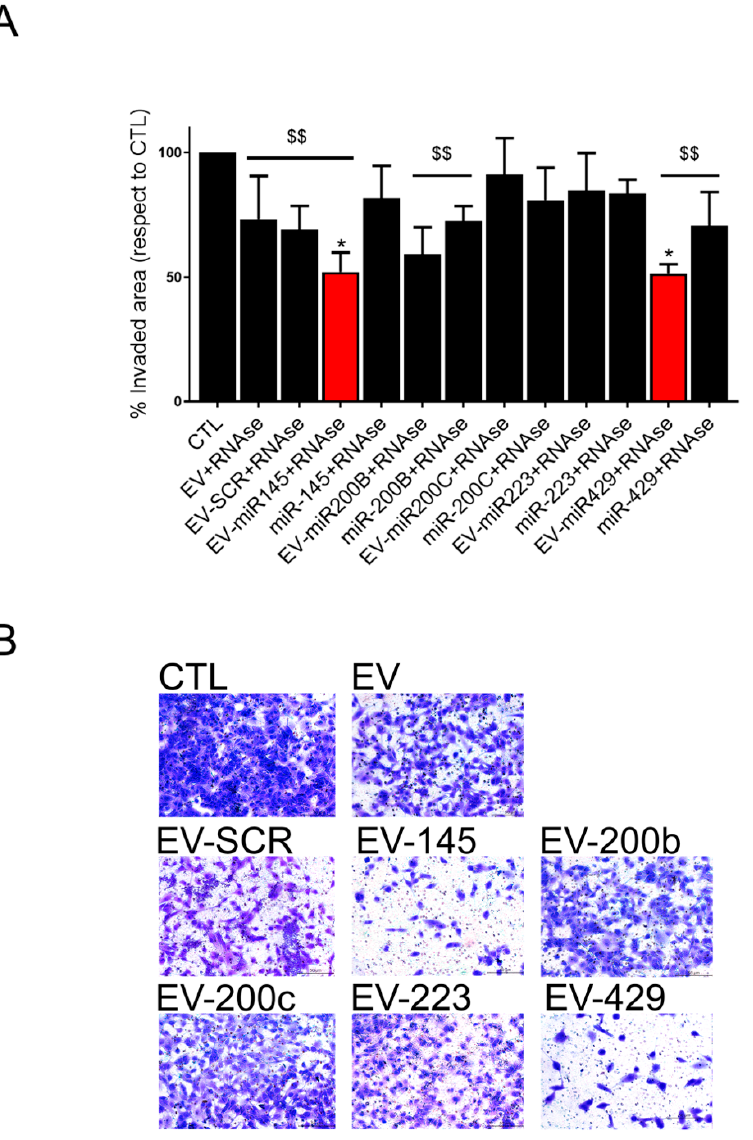
Figure 4. Anti-invasive effects of coincubation invasion assay quantification ( A ) and representative micrographs (( B ), original magnification: 100×) of rCSCs treated for 48 h with naïve HLSC-EVs (EV), or with HLSC-EVs coincubated with a scrambled sequence or with anti-tumor miRNAs (miR-145, miR200b, miR200c, miR223 and miR429) and digested with RNase-A (EV-miR + RNase). miRNAs alone digested with RNase were used as controls (miR + RNase). Data are represented as mean of the percentage of invaded area of at least two experiments performed in triplicate. An ANOVA analysis was performed: * = p < 0.05 vs. EV; $$ = p < 0.001 vs. untreated rCSCs